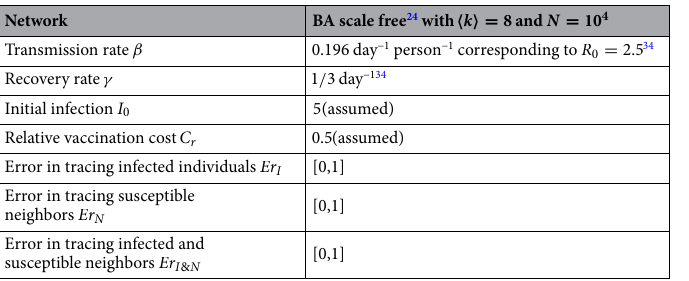
Table 2. Relevant parameters and their values used in multi-agent simulations. These values have been presumed throughout unless stated